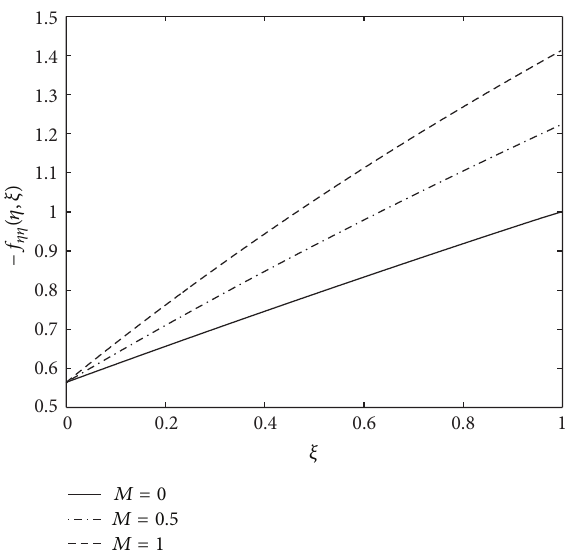
Figure 1: CFDRM solution of −𝑓 󸀠󸀠 (0, 𝜉) for different values of 𝑀 for Example